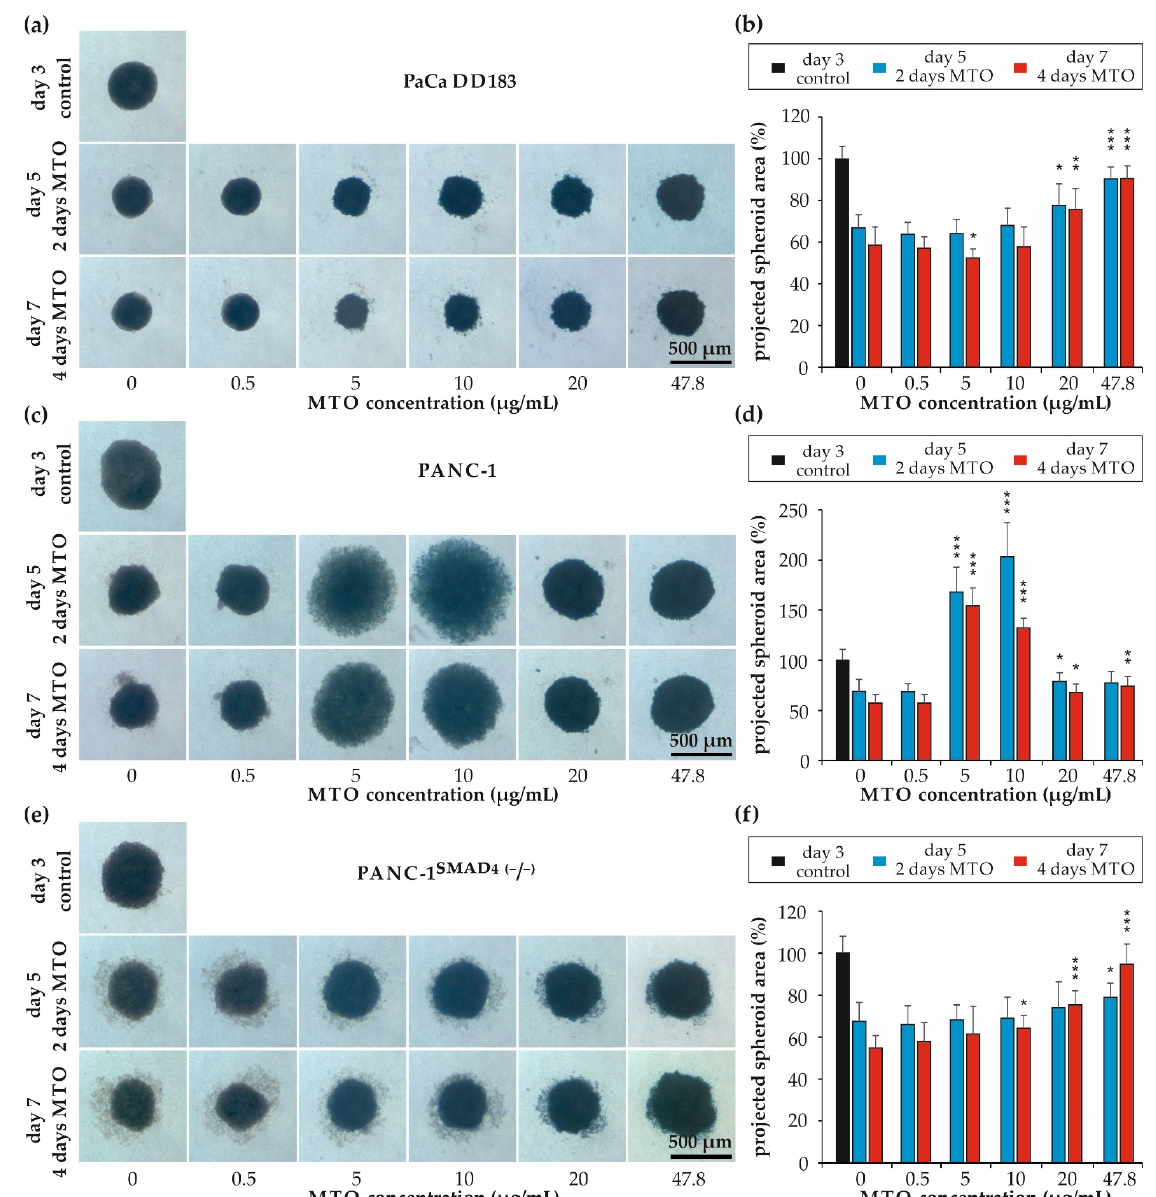
Figure 2. Effect of free MTO on pancreatic spheroids. Transmission microscopy images and quantification of representative spheroids formed by ( a , b ) PaCa DD183, ( c , d ) PANC-1 and ( e , f ) PANC-1 SMAD4 ( − / − ) spheroid cells after three, five and seven days of incubation. On day three, cell culture medium was supplemented with MTO (0, 0.5, 5, 10, 20 and 47.8 µg/mL, respectively). Growth progression was normalized to the spheroid size at day 3. Data are expressed as the mean with standard deviation ( n = 4, with three replicates each). Statistical significances between MTO-free and MTO-treated spheroids are indicated with *, ** and ***. The respective confidential intervals are * p ≤ 0.05, ** p ≤ 0.0005 and *** p ≤ 3 × 10 − 9 , respectively, and were calculated via the Student’s t -test. Abbreviations: MTO, mitoxantrone.